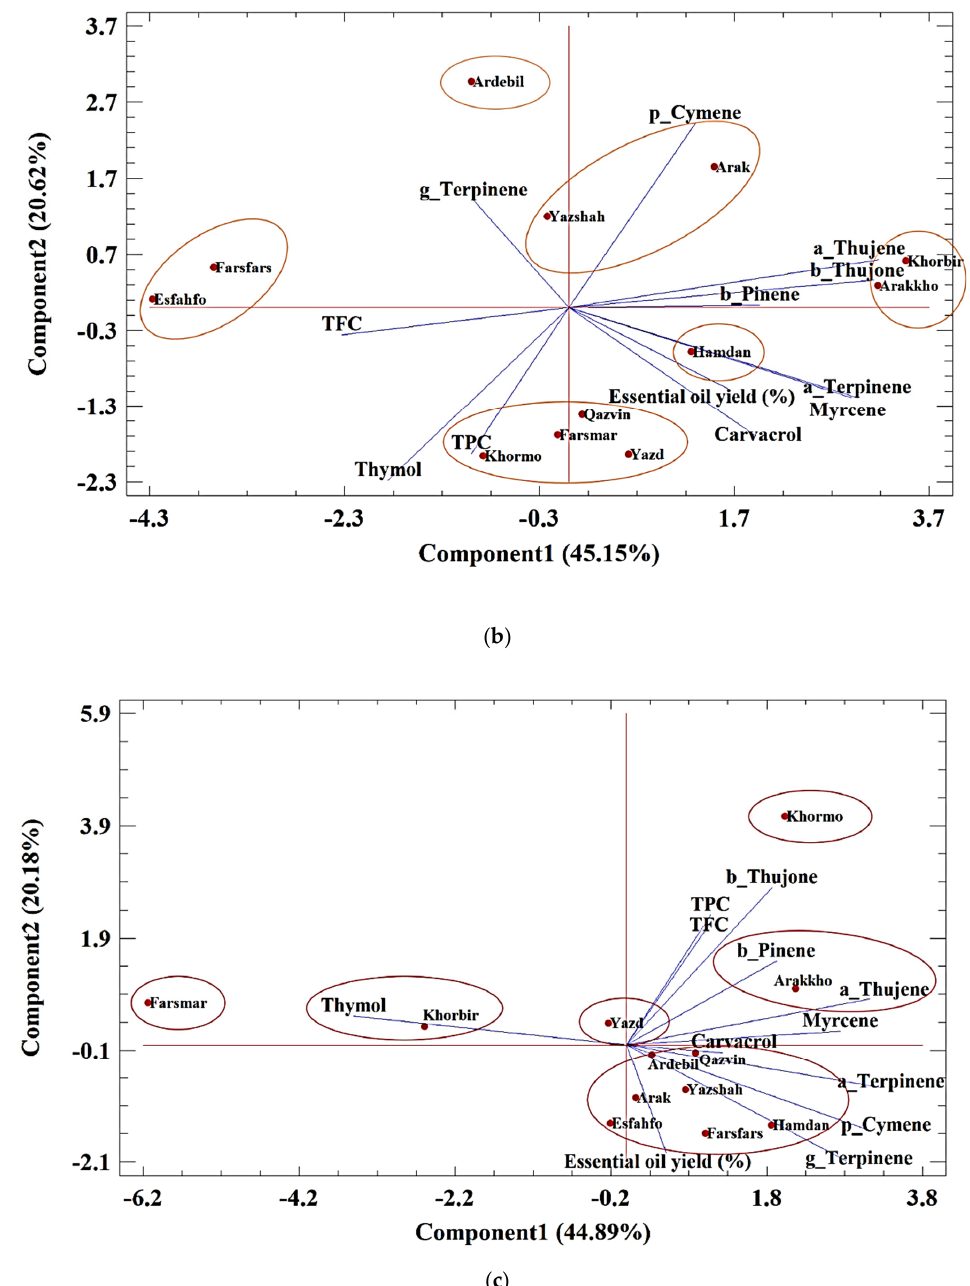
Figure 1. ( a – c ) . PCA analysis for classification of 12 ajowan populations based on bioactive compounds in ( a ) normal conditions, ( b ) moderate drought stress conditions, and ( c ) severe stress